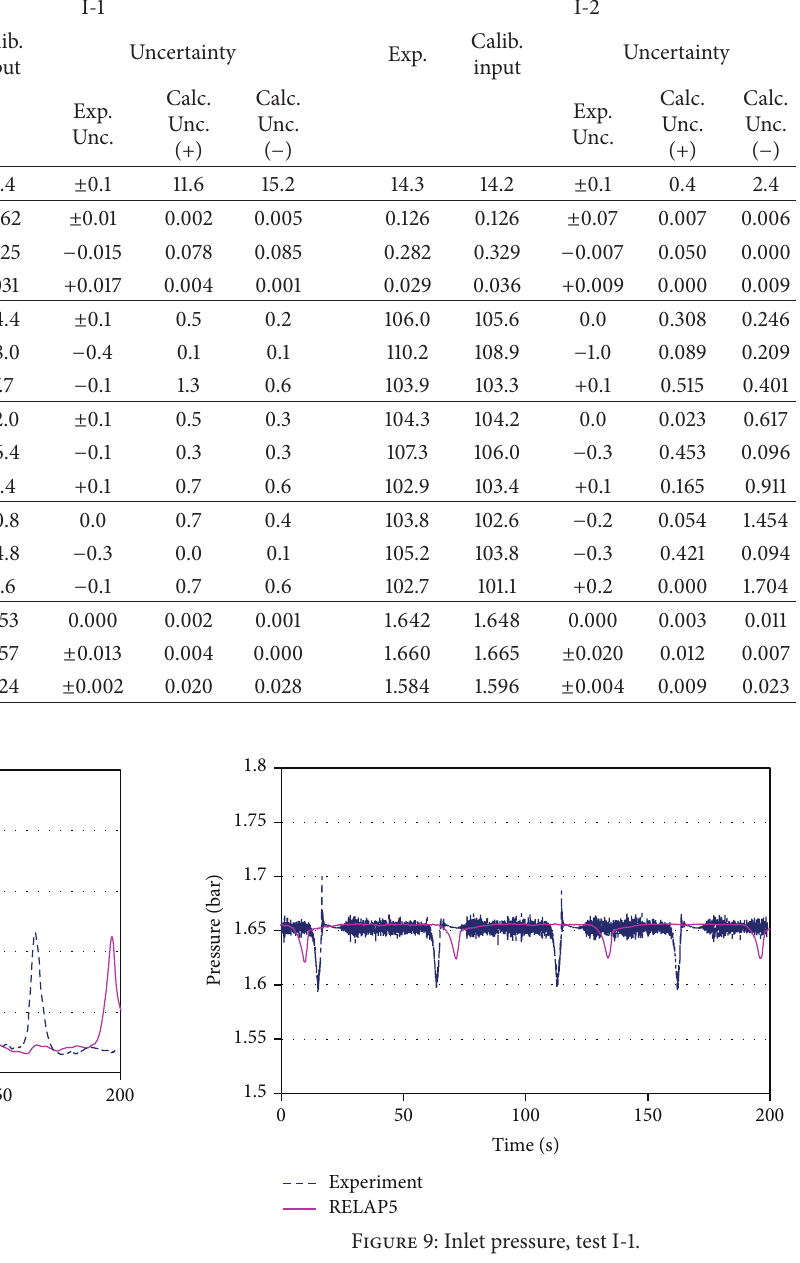
Table 7: Calculated and experimental values with uncertainties.